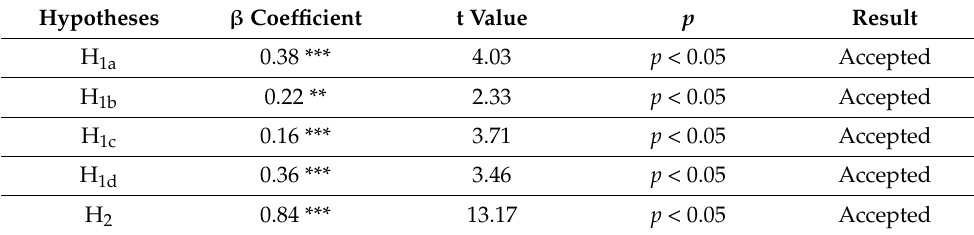
Table 4. Tested results of